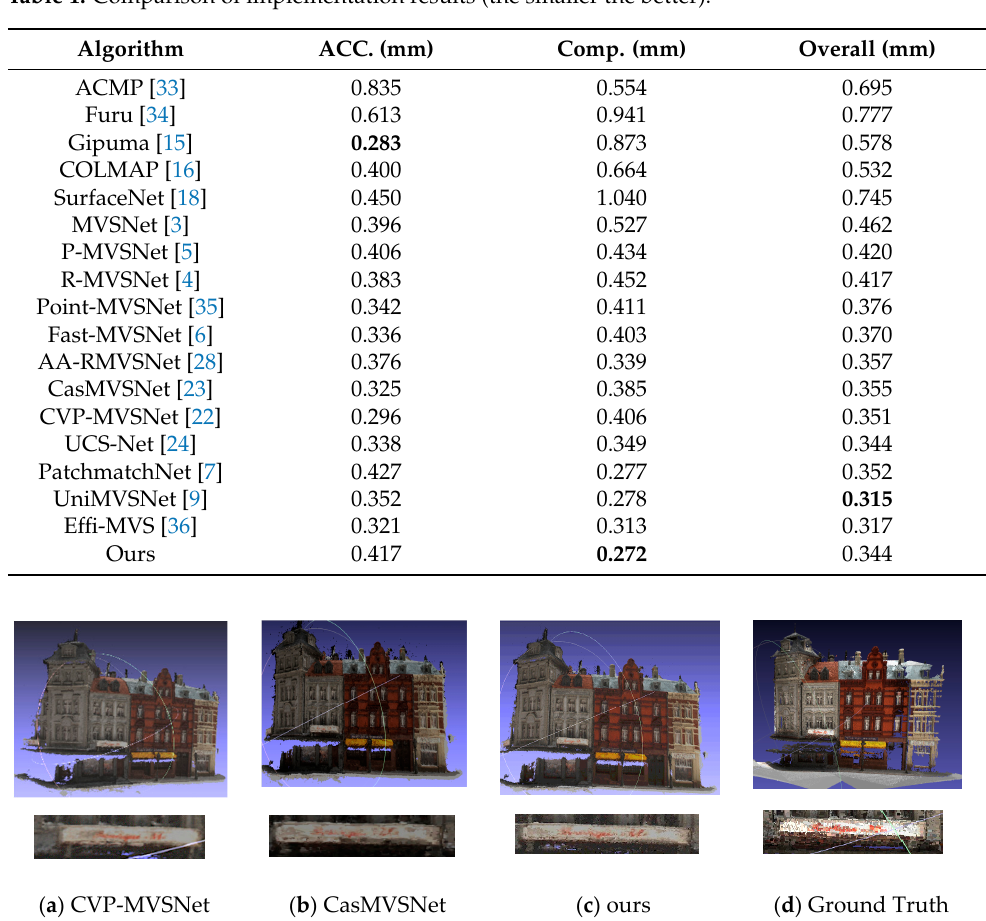
Table 1. Comparison of implementation results (the smaller the better).